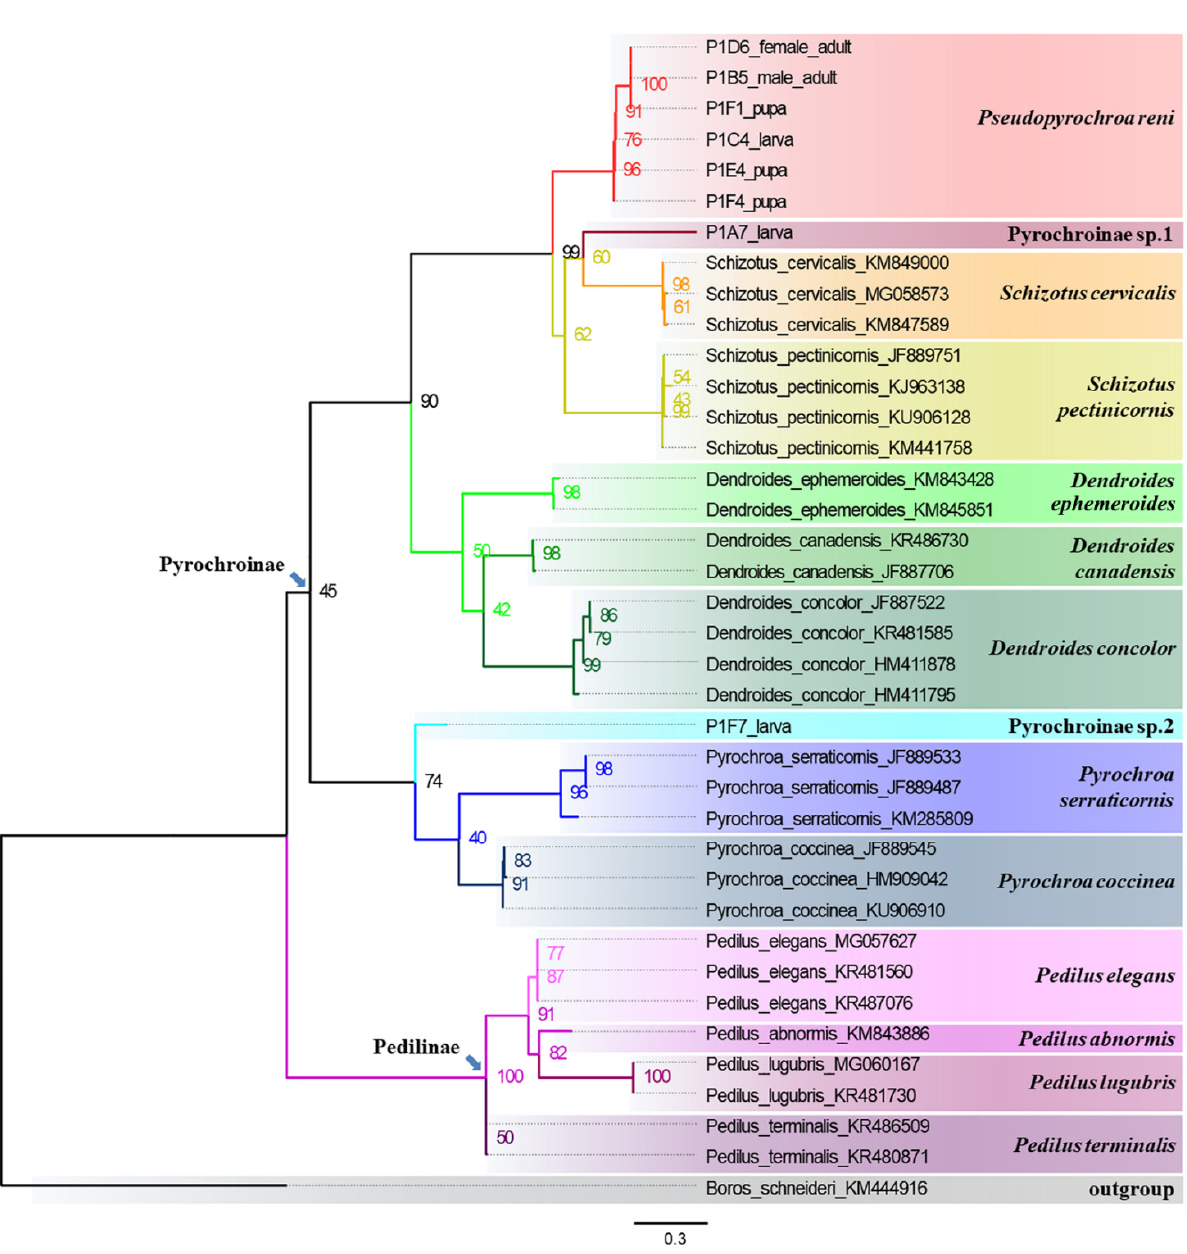
Figure 7. Maximum likelihood phylogenetic tree based on COI sequence data. Support for each node is represented by ultrafast bootstrap values (uBV, %).